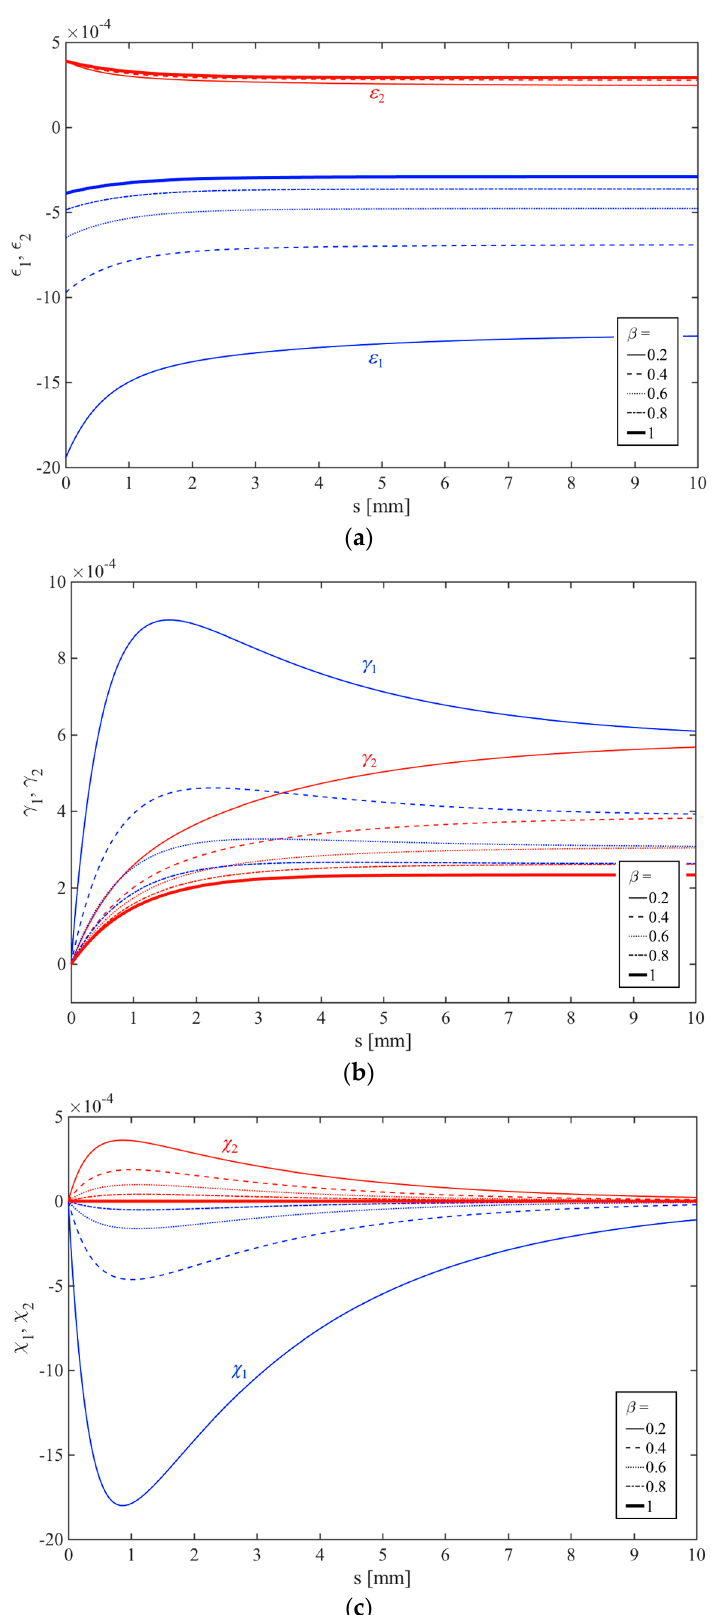
β Figure 20. Effect of the mechanical ratio on the strain field: ( a ) Axial strain; ( b ) Shear strain; ( c ) Figure 20. Effect of the mechanical ratio β on the strain field: ( a ) Axial strain; ( b ) Shear strain; Curvature. (Isotropic specimen). ( c ) Curvature. (Isotropic